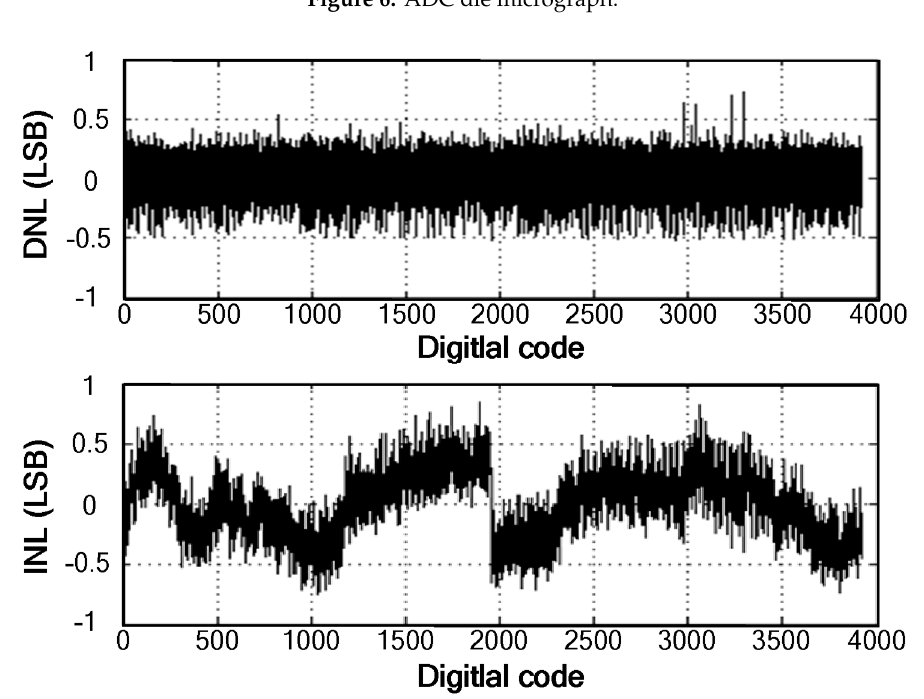
Figure 7. Measured DNL and INL.